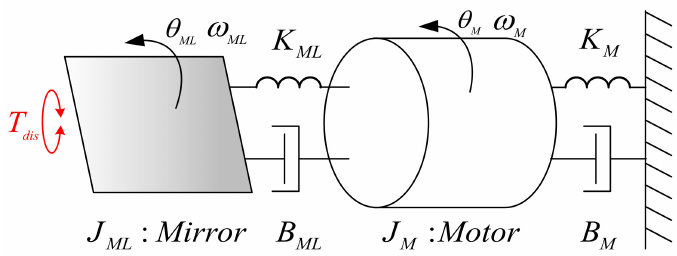
Figure 6. Equivalent model of the PM motor with